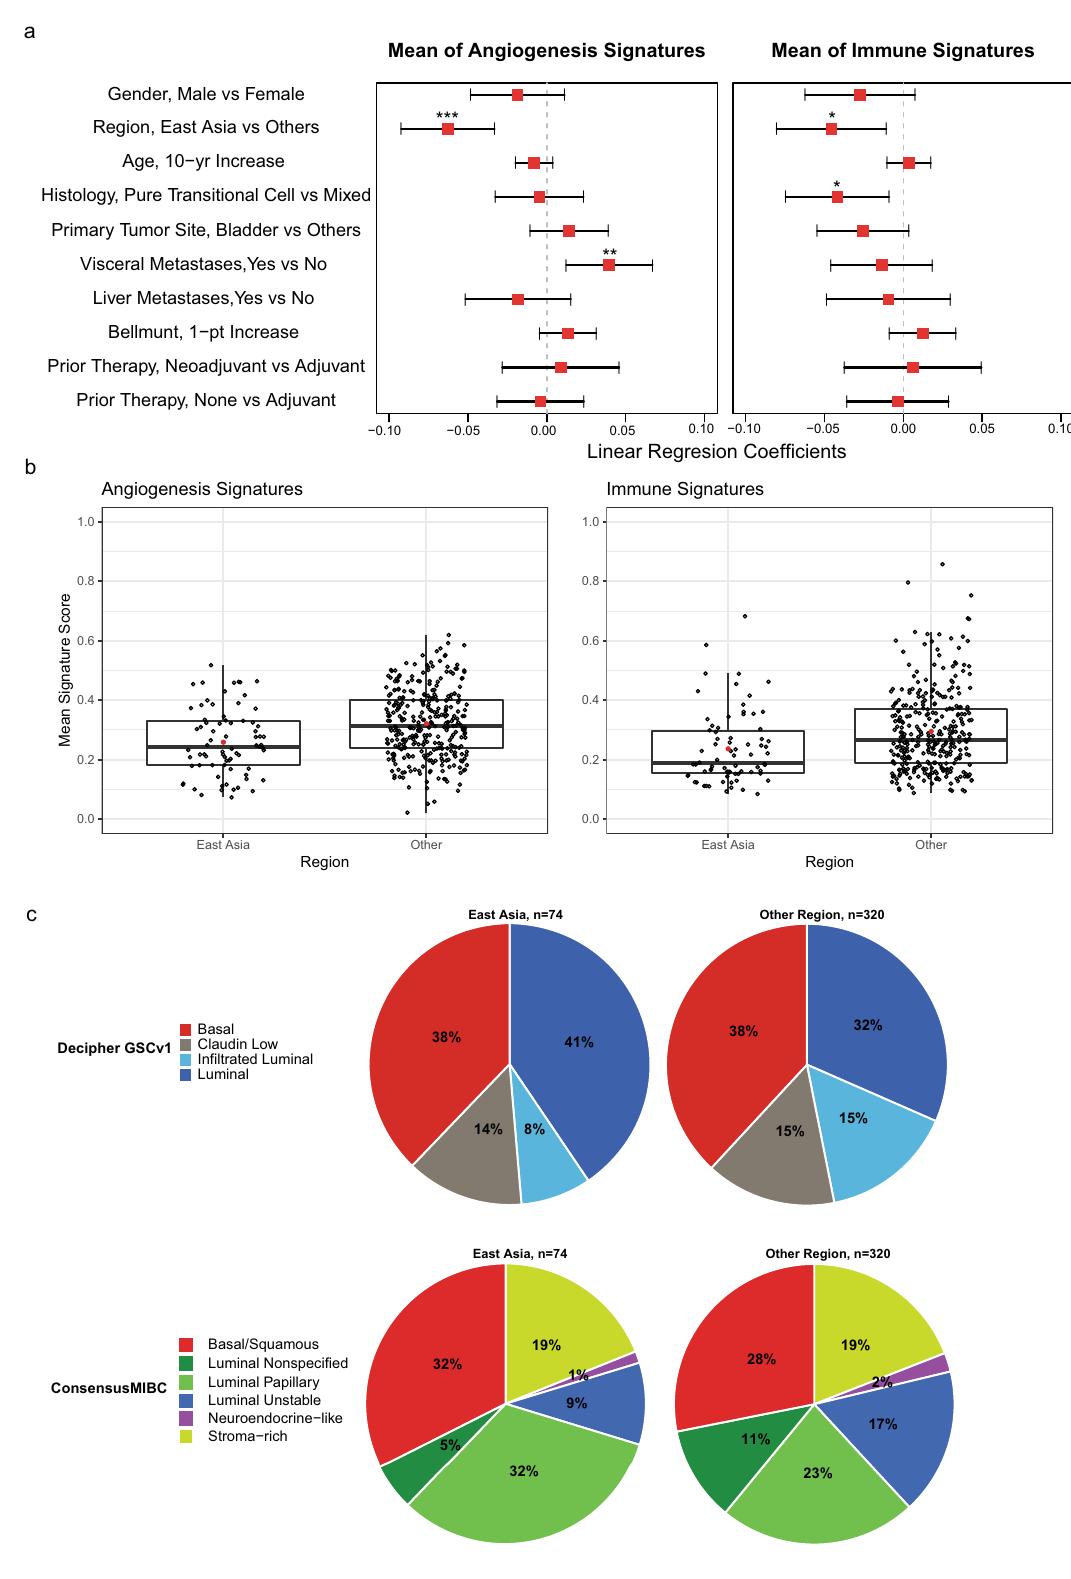
angiogenesis as potential markers for response. In addition, the exploratory analysis from the RANGE trial 19 , showing that PD-L1 CPS ≥ 10 was associated with signi fi cant OS treatment effect, prompted us to further investigate immune-related gene signatures. Our analysis revealed that high-PD-L1 expression correlated with